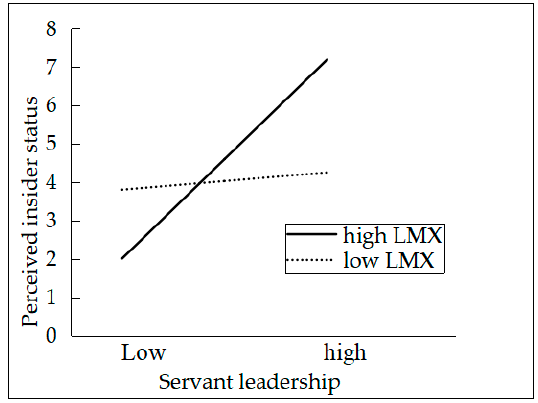
Figure 2. The interaction between servant leadership and LMX on PIS. Int. J. Environ. Res. Public Health 2020 , 17 , x FOR PEER REVIEW